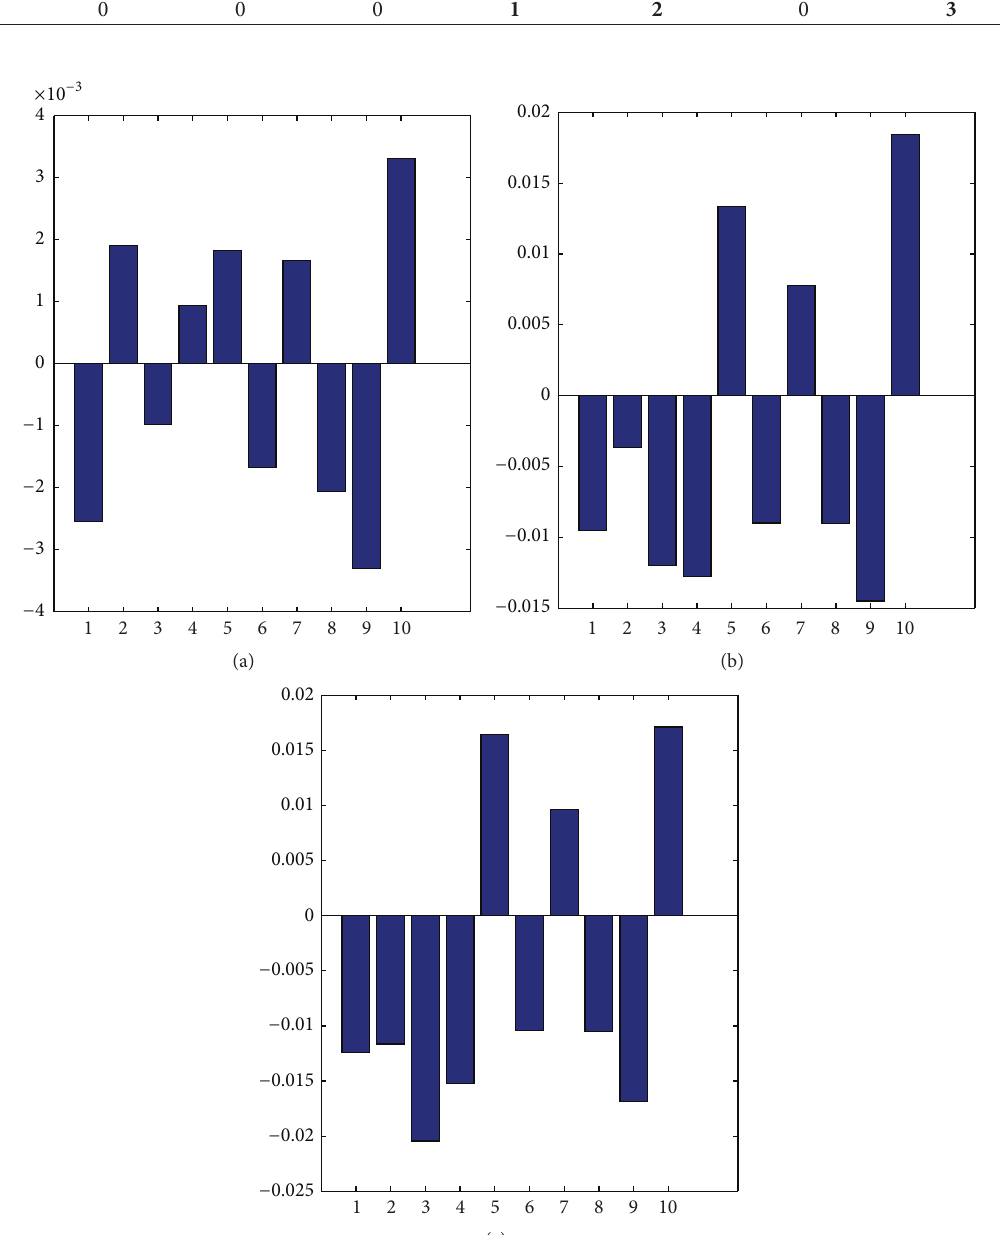
Figure 5: Sensitivity comparison of different component fault: (a) LPC, (b) HPC, and (c)